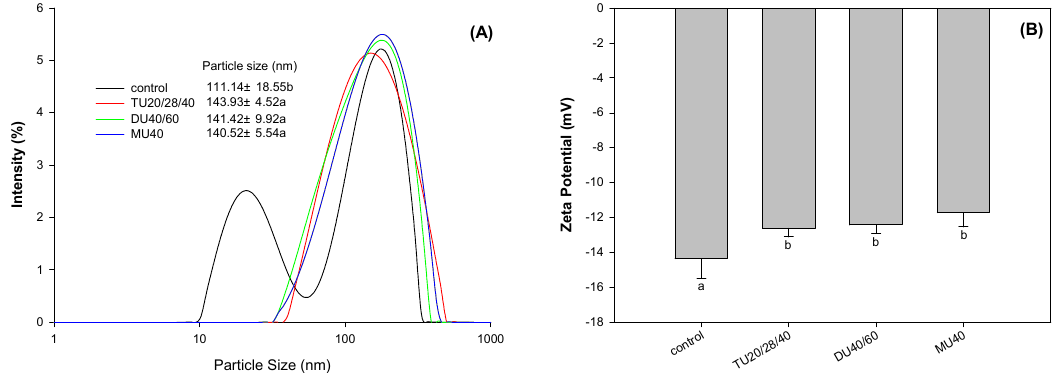
Figure 7. E ff ects of online-US / T40 / pHS treatment at the frequency of TU20 / 28 / 40, DU40 / 60, Figure 7. Effects of online-US/T40/pHS treatment at the frequency of TU20/28/40, DU40/60, and MU40 and MU40 kHz on average particle size and particle size distribution ( A ) and zeta-potential ( B ) kHz on particle size distribution and zeta-potential of potato protein. Means with different letters (a– of potato protein. Means with di ff erent letters (a–b) di ff er significantly ( p < b) differ significantly ( p < 0.05).